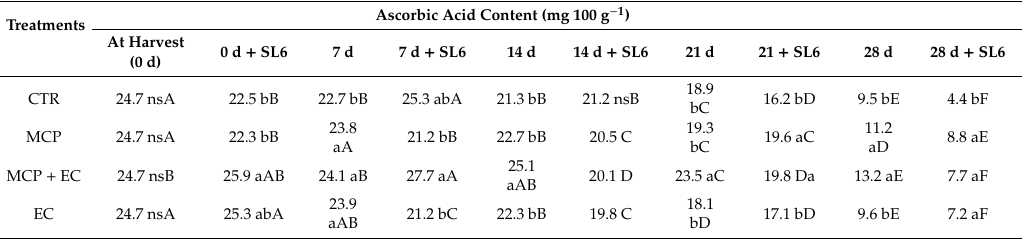
Table 2. Vitamin C, expressed as ascorbic acid equivalents (mg) per 100 g fresh weight (FW) of four di ff erent